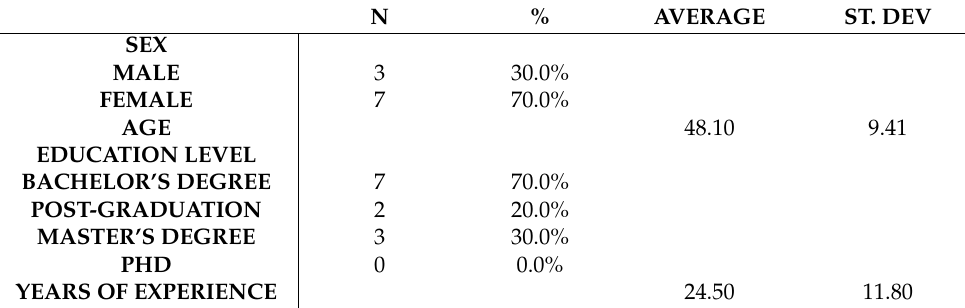
Table 1. Pharmacists’ demographic